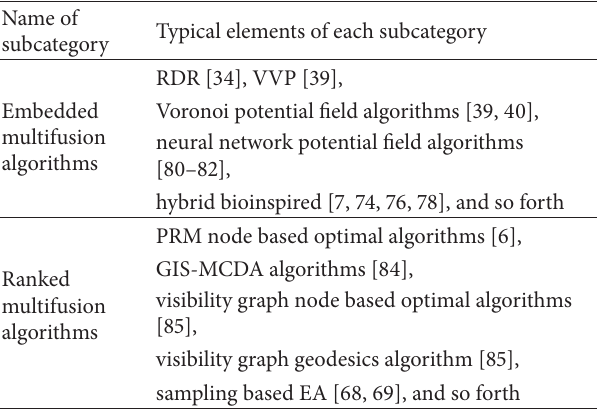
Table 6: Typical elements of multifusion based